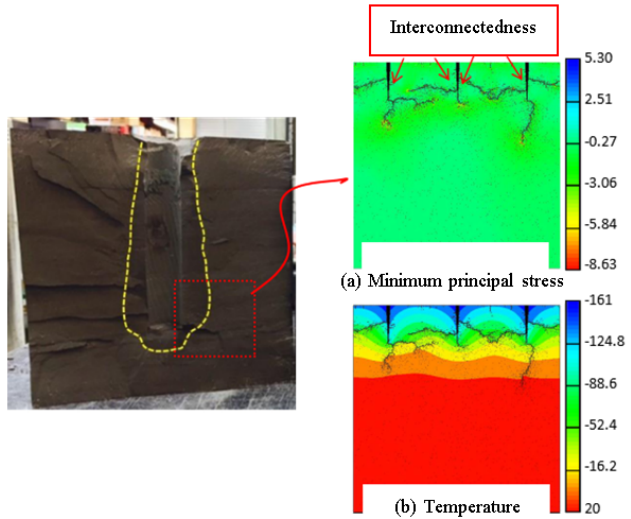
Figure 22. Temperature distribution and the minimum principal stress and crack propagation process under the condition of thermal shock for the second time.